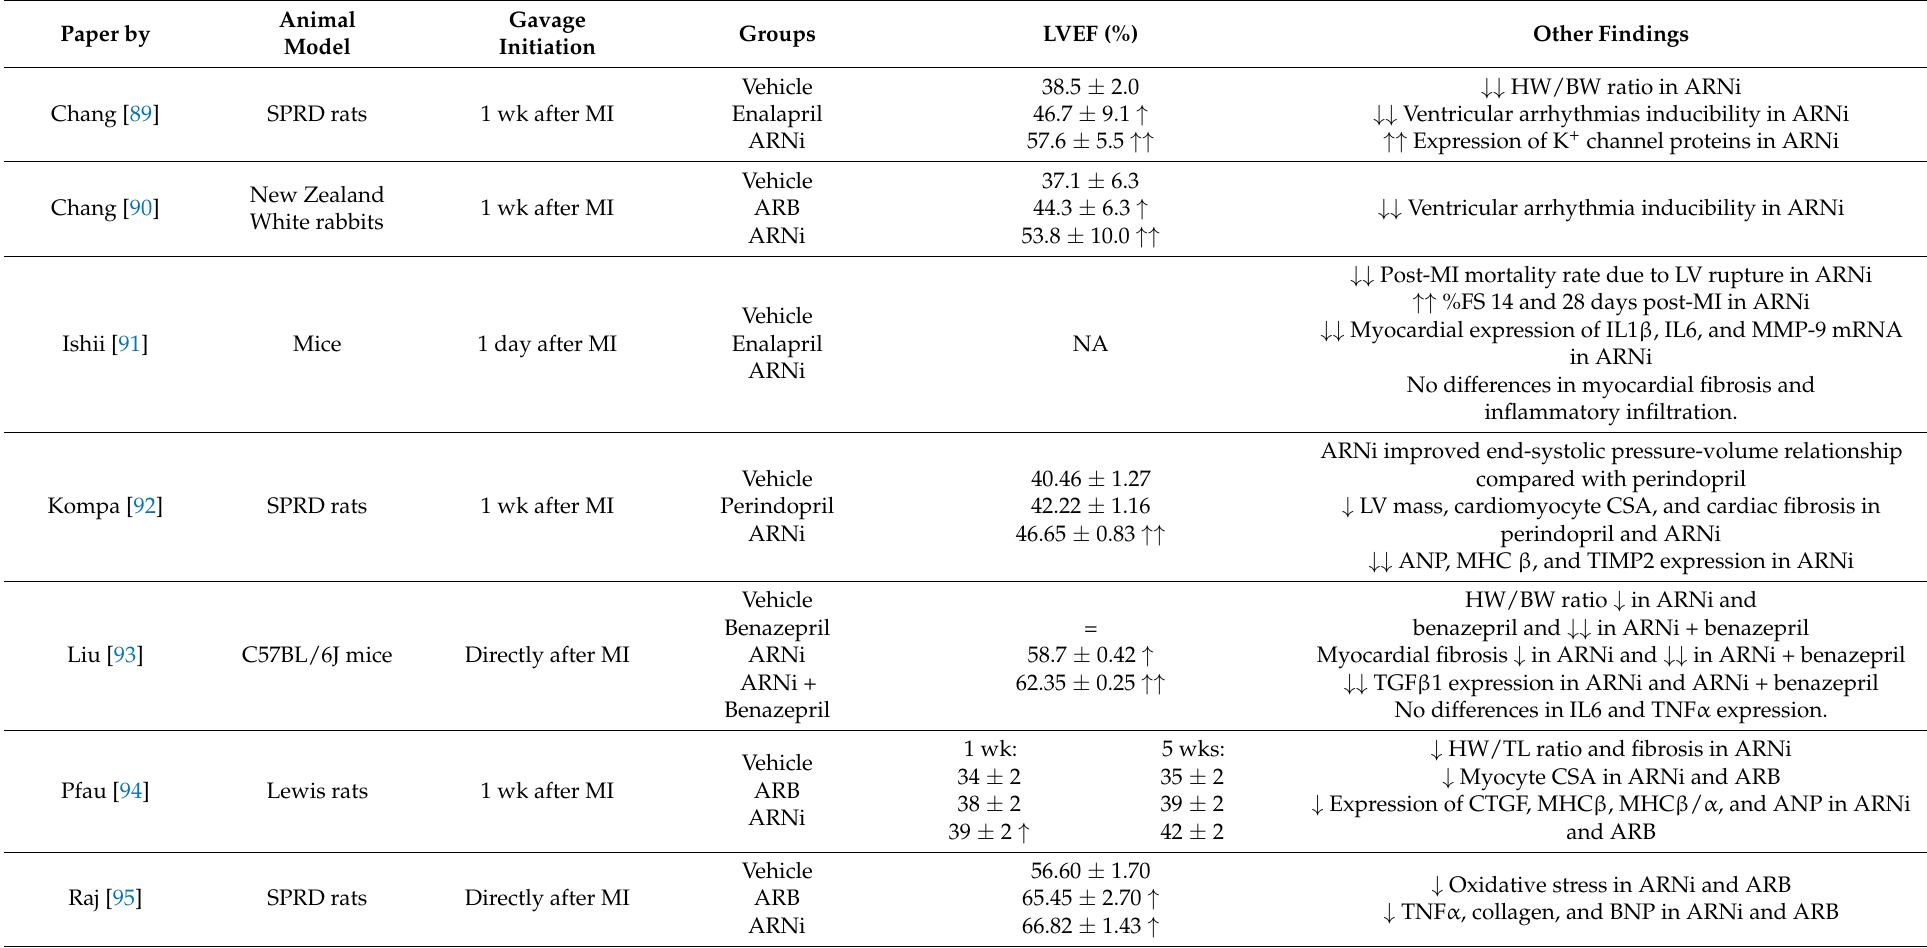
Table 1. ARNi administration in preclinical models of